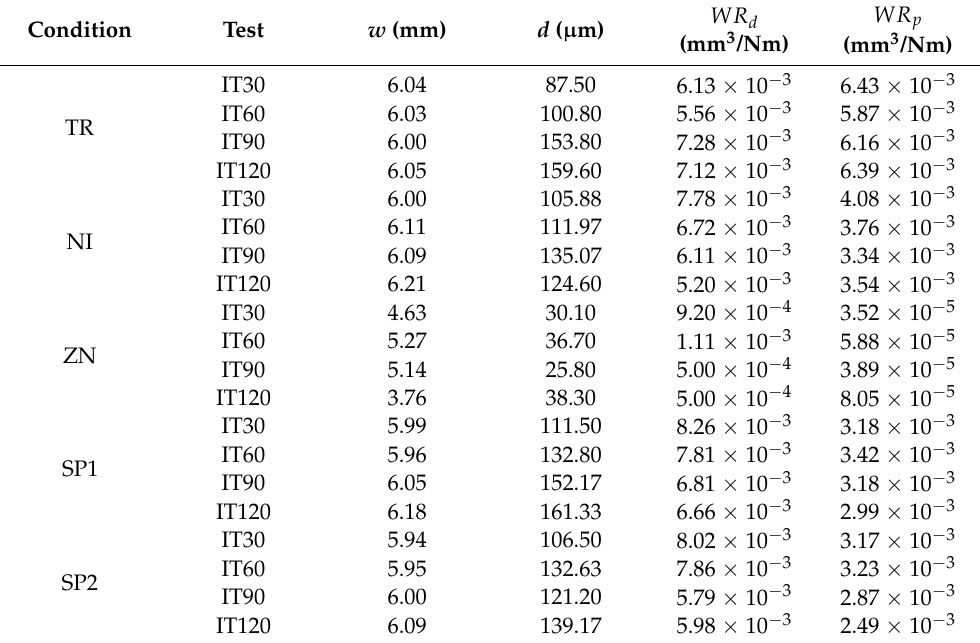
Table 9. Variation of w , d , WR d , and on the pins WR p at 1 Hz sliding frequency. Condition